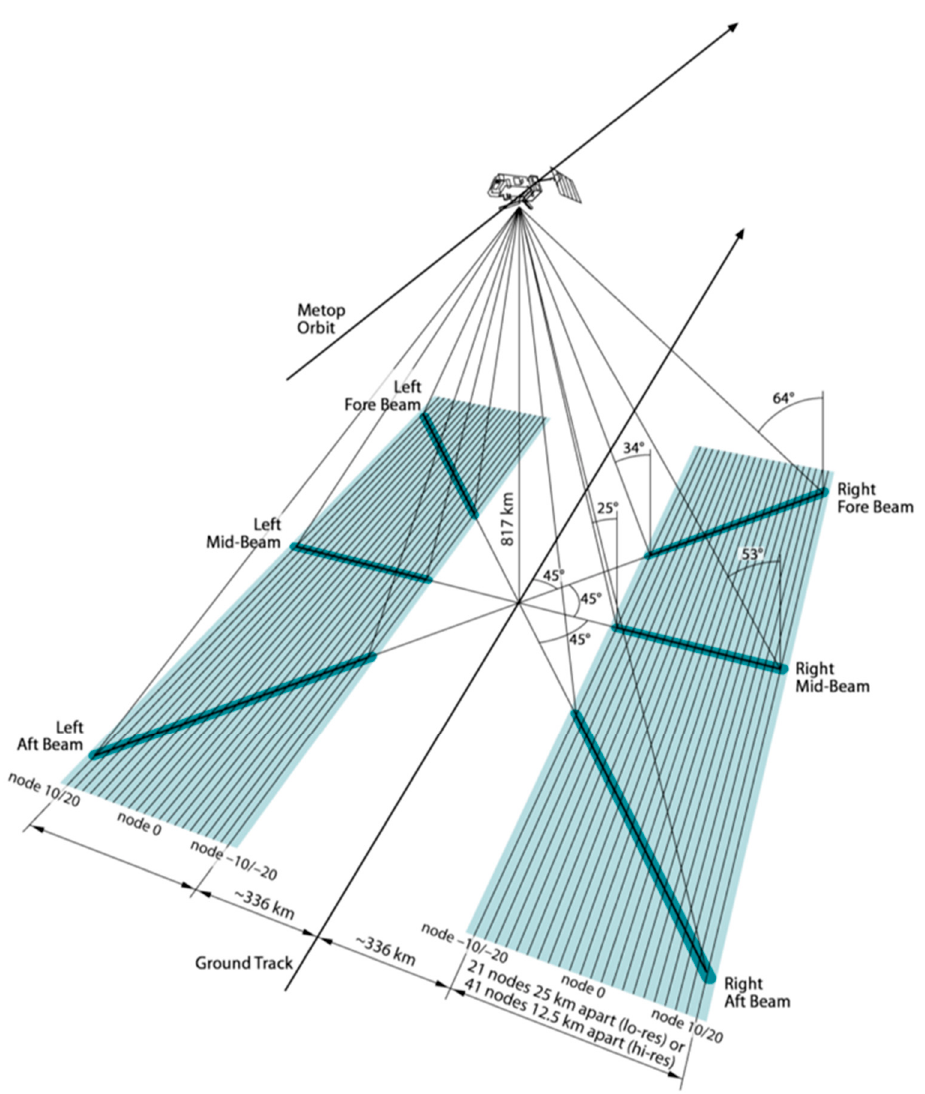
Figure 1. An example of the three fixed fan-beam scatterometer geometry of ASCAT [17].